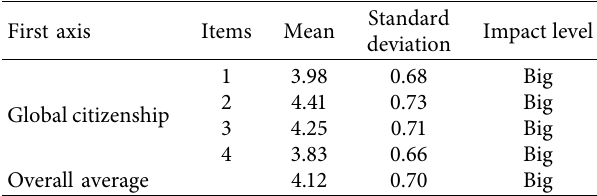
Table 5: Arithmetic averages and standard deviations of the third axis.